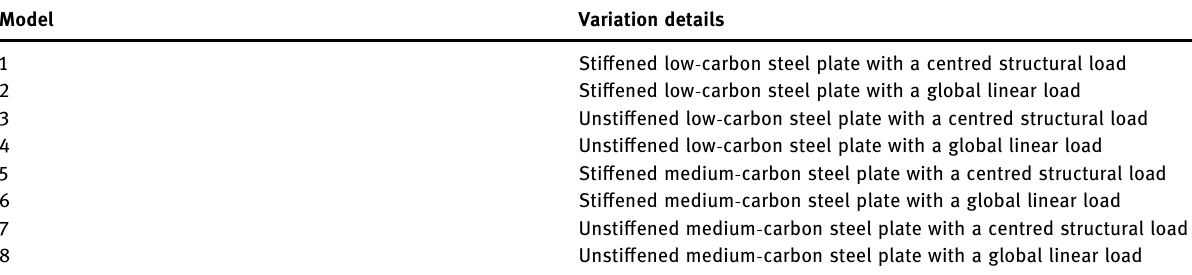
Table 3: Eight main variation models Model Variation